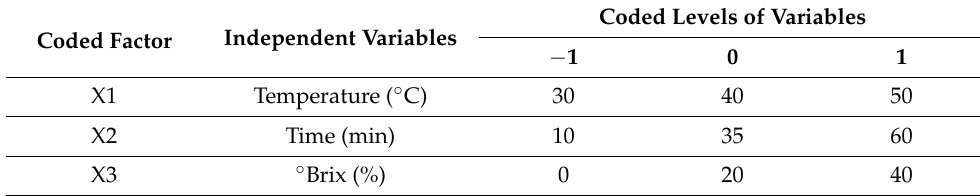
Table 1. The level of coded values used for the osmotic dehydration process.